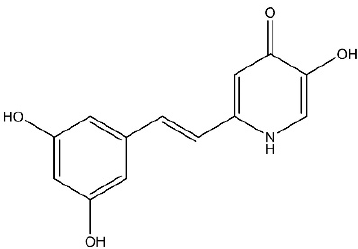
Figure 1. Chemical structure of DFP-RVT hybrid (Redrawn from [23]).